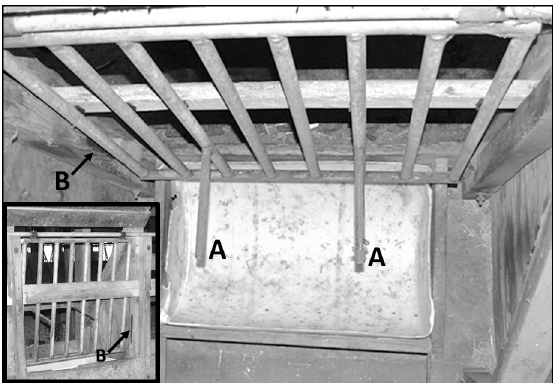
Fig 1. Trough with weighted gate heifers had to push to access hay. The main photo is an overhead view of the outside of the gated trough, and the inset shows the gate from inside the pen. The gate had 2 bars (A) to which weight plates were added. A black line (B) was painted on the wall to mark the position of the gate when fully closed.